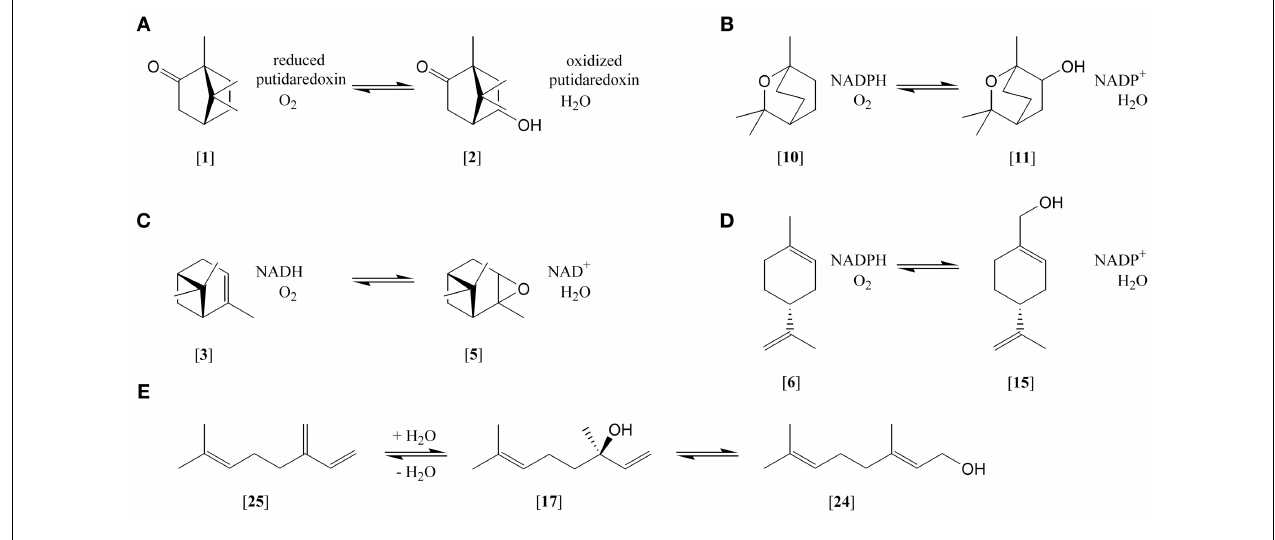
α -pinene oxide [5]; (D) ( R )-limonene [6] hydroxylation to perillyl alcohol [15]; (E) myrcene [25] hydration to ( S )-( + )-linalool [17] and isomerization to geraniol